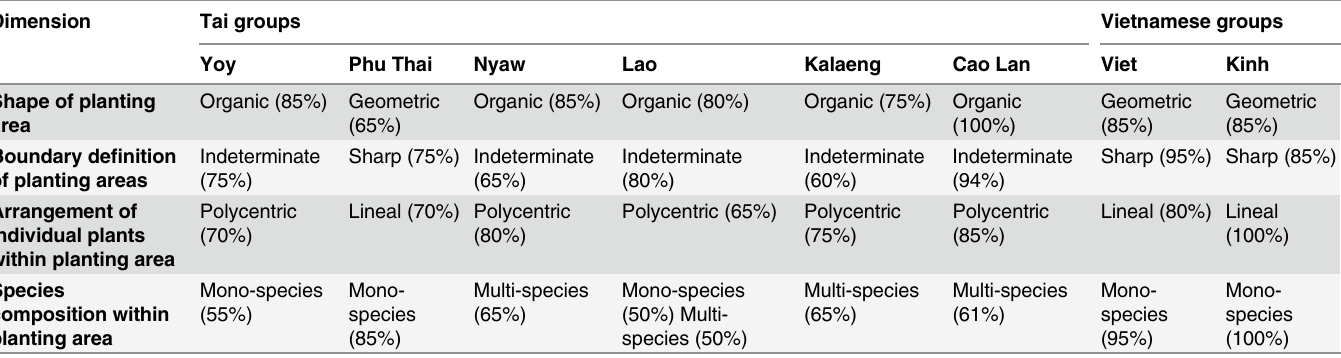
Table 3. Comparison of modal structural characteristics of homegardens of different ethnic groups in Northeast Thailand and Vietnam (% of homegardens with all or > 50% of their area displaying each characteristic) (n = 20, except 17 for Cao Lan). Dimension Tai groups Vietnamese groups